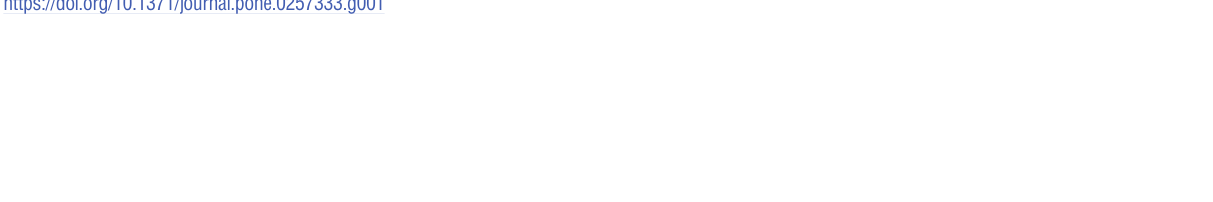
PLOS ONE | https://doi.org/10.1371/journal.pone.0257333 September 10, 2021 5 /